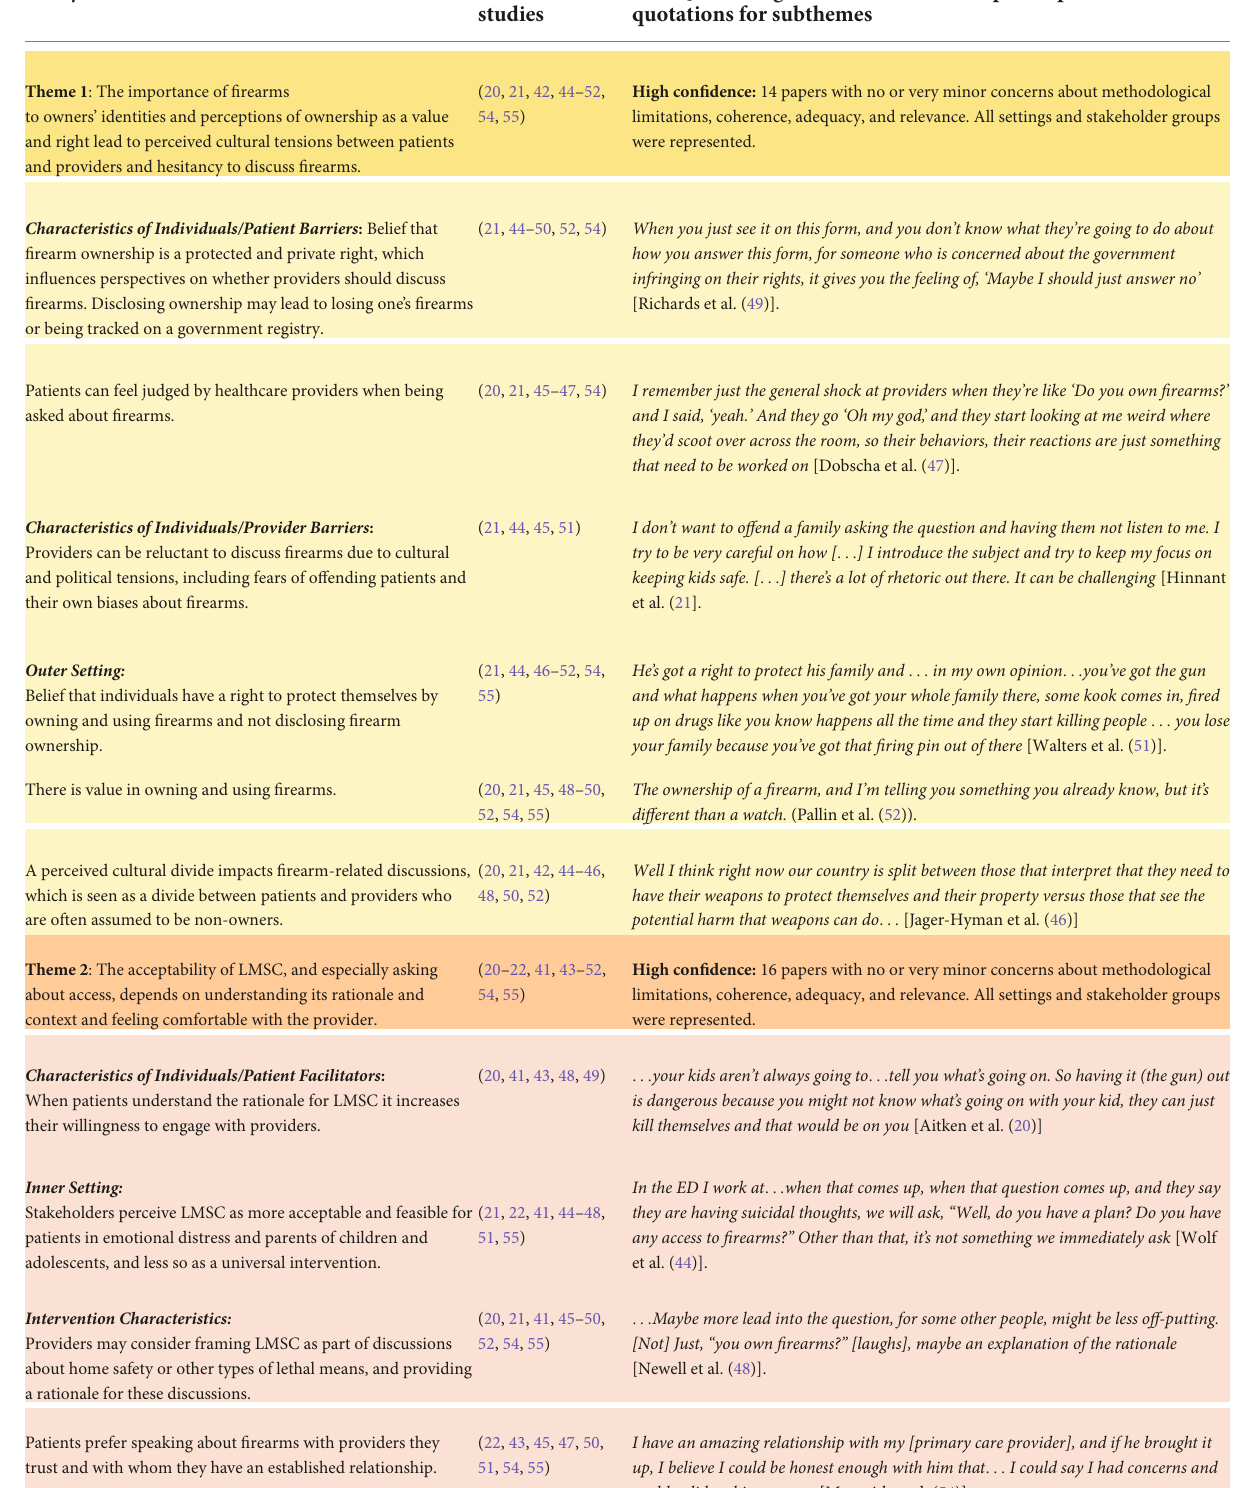
TABLE 3 Summary of findings by analytic themes and subthemes, organized by CFIR